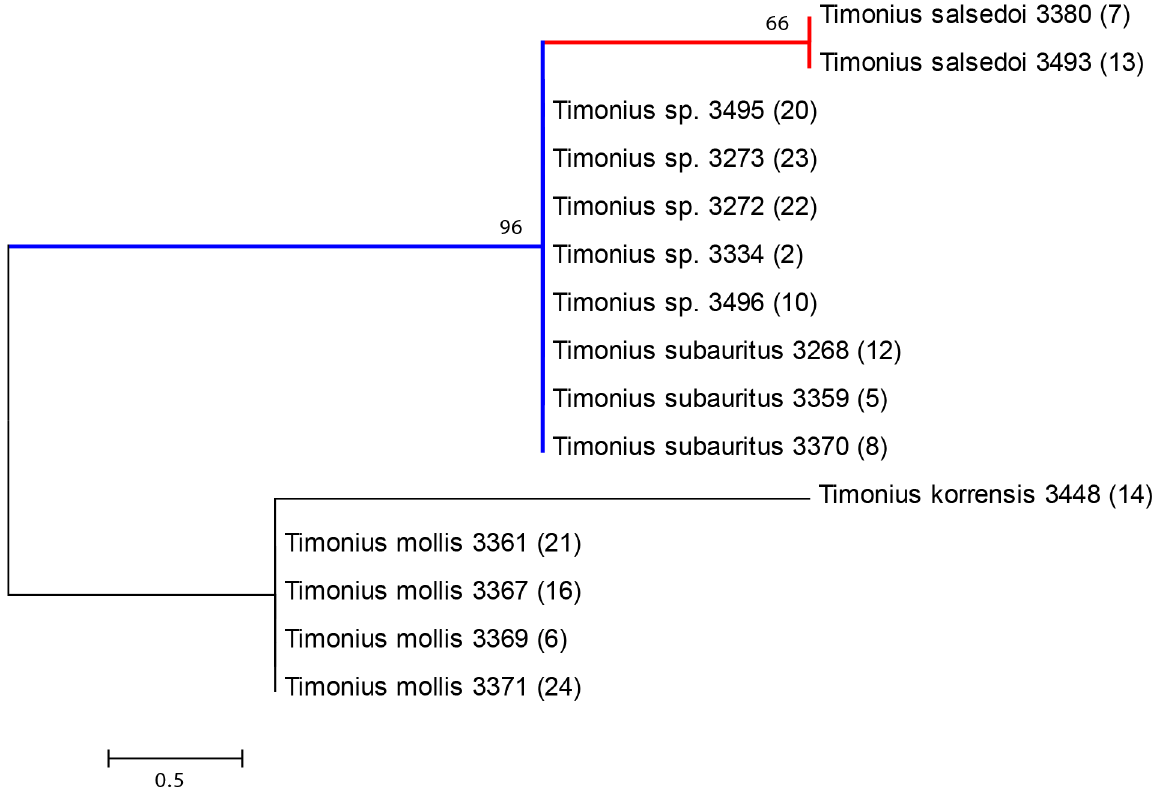
Fig 4. Neighbor-joining tree from seven-locus alignment ( rbcL , matK , ITS , trnH-psbA , trnL-trnF , petD , atpB-rbcL ) with bootstrap support values at branch nodes and species followed by collection number (DNA sample number) at the branch tips. The tree is drawn to scale, with branch lengths in the same units as those of the evolutionary distances used to infer the phylogenetic